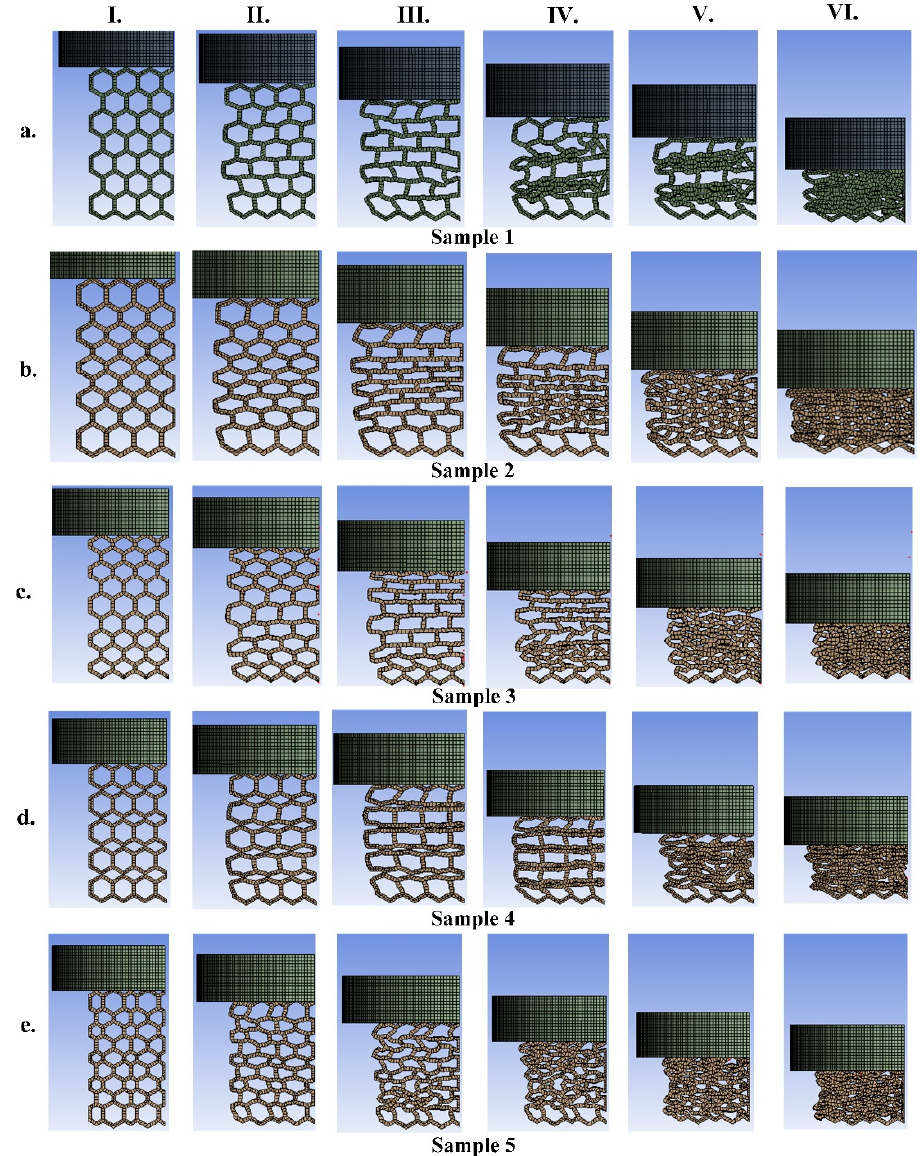
Figure 8. The deformation mapping of the samples 1 to 5 ( a – e ) made of PA12 (each configuration from I to VI represents the current configuration at different displacements from 0.0033 to 0.02 m, with displacement increment of 0.00334 m).